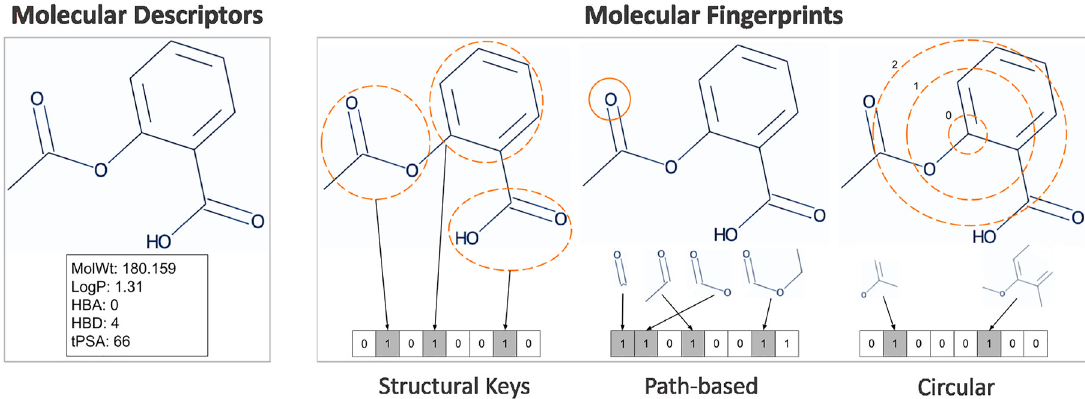
Figure 1: Traditional representations of compounds for machine learning tasks.